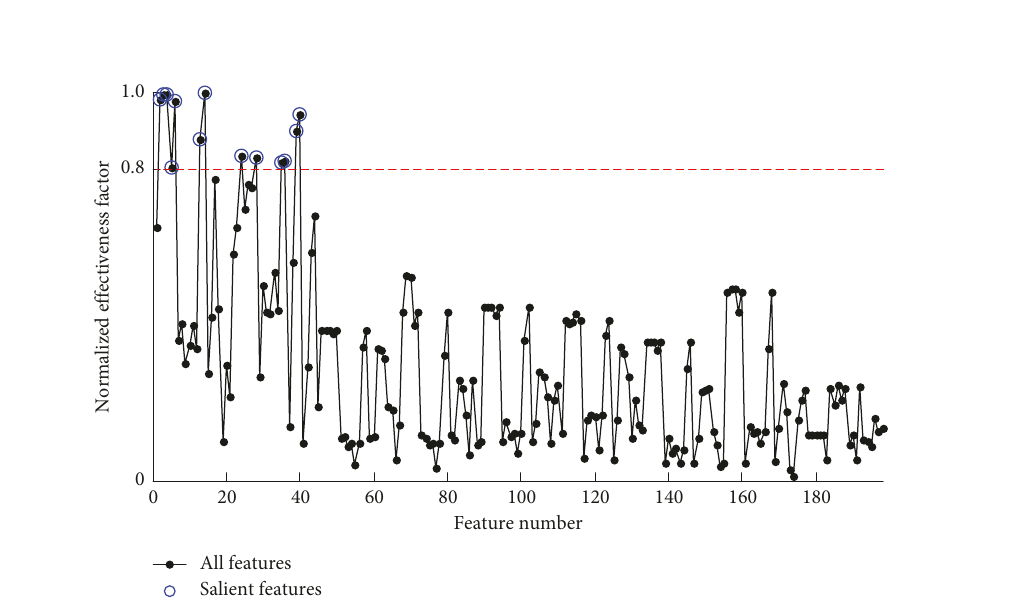
Figure 17: Salient features when ASNBD is applied in experiment